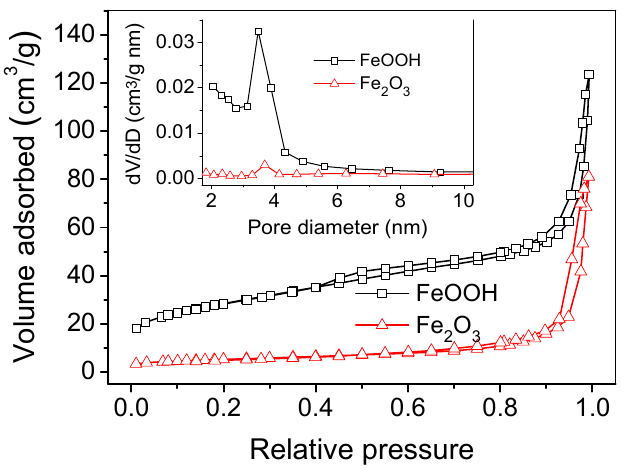
Figure 2. N 2 adsorption–desorption isotherms and Barrett–Joyner–Halenda (BJH) pore size distribution curves of the support materials. Table 1. Textural properties of the support materials.